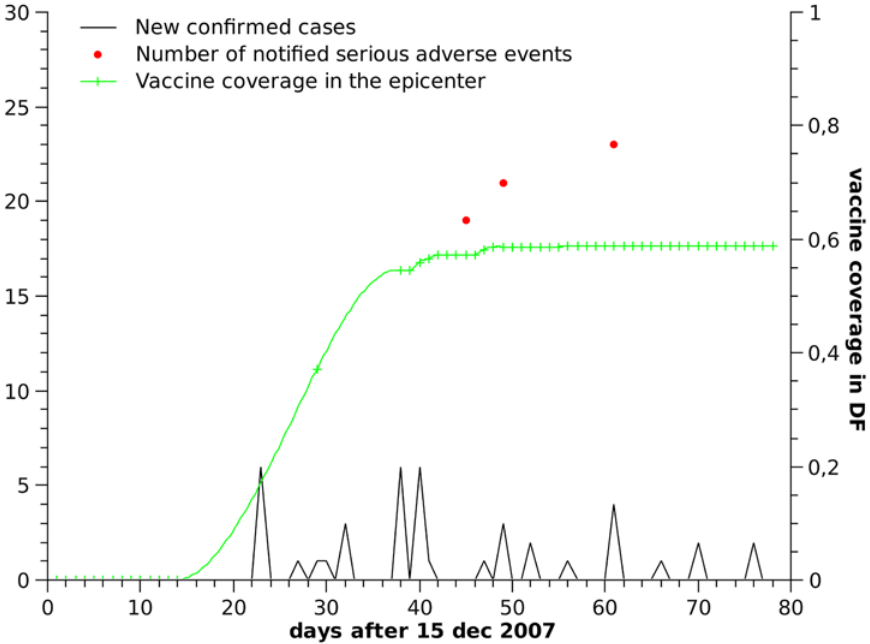
Figure 1. Yellow fever cases, vaccination coverage, and adverse vaccination events. Coverage data is from Brasilia, which was the epicenter of the outbreak.